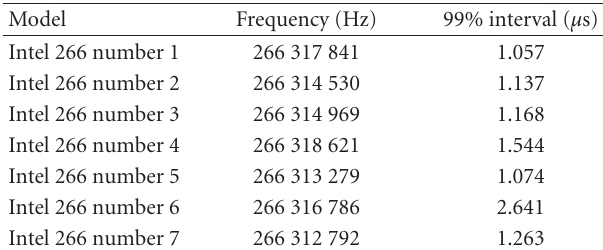
Table 5: Clock frequency for 7 Intel Pentium II 266MHz micropro- cessors.